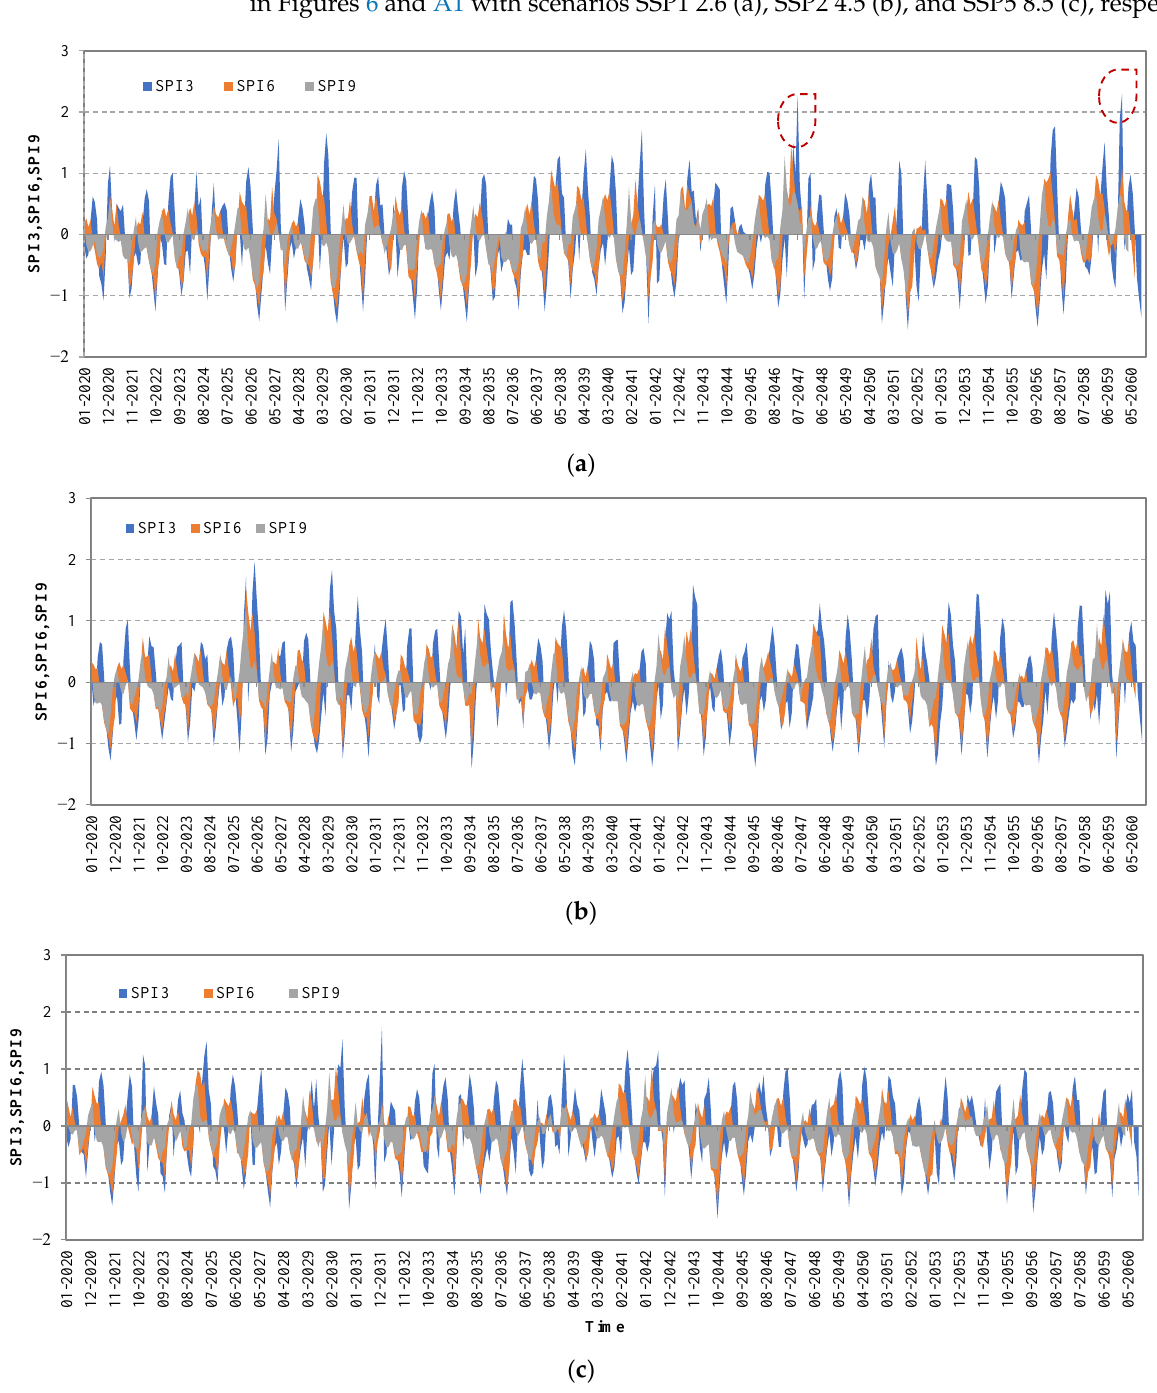
Figure 6. Different time series (SPI 3, SPI 6, SPI 9) for monthly drought patterns at Chau Doc meteorological station using various climate change scenarios, SSP1 2.6 ( a ), SSP2 4.5 ( b ), and SSP5 8.5 ( c